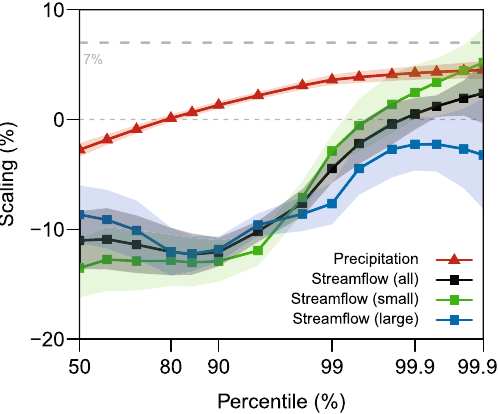
Figure 3. Precipitation and streamflow scaling with exceedance percentile demarcated on catchment area for South East Australia. Streamflow scaling for small catchments is in green, for large catchments in blue, and for all catchments in black. Precipitation scaling is in red. Shading represents 90% confidence limits. Scaling is calculated using linear regression on the percentiles for the temperature range 10 °C–20 °C as presented in Fig. 2. As a reference, the thick grey dashed line represents the approximate Clausius-Clapeyron scaling of 7%. Figure was created using the statistical software ‘R’ 61